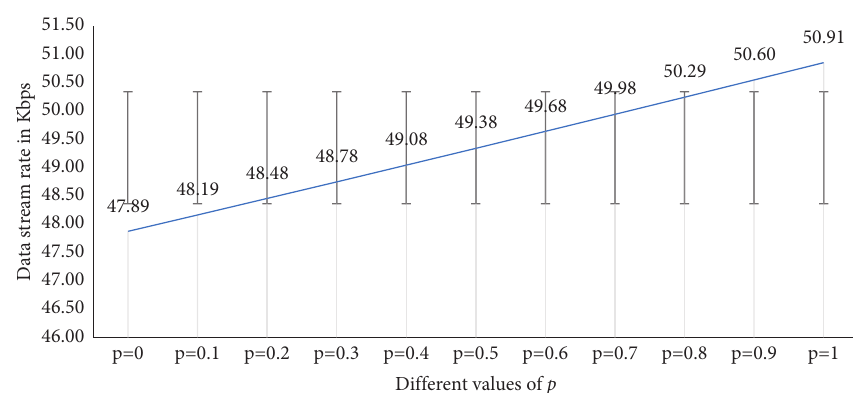
Figure 2: Graphical representation of change of data stream ( 􏽥 x